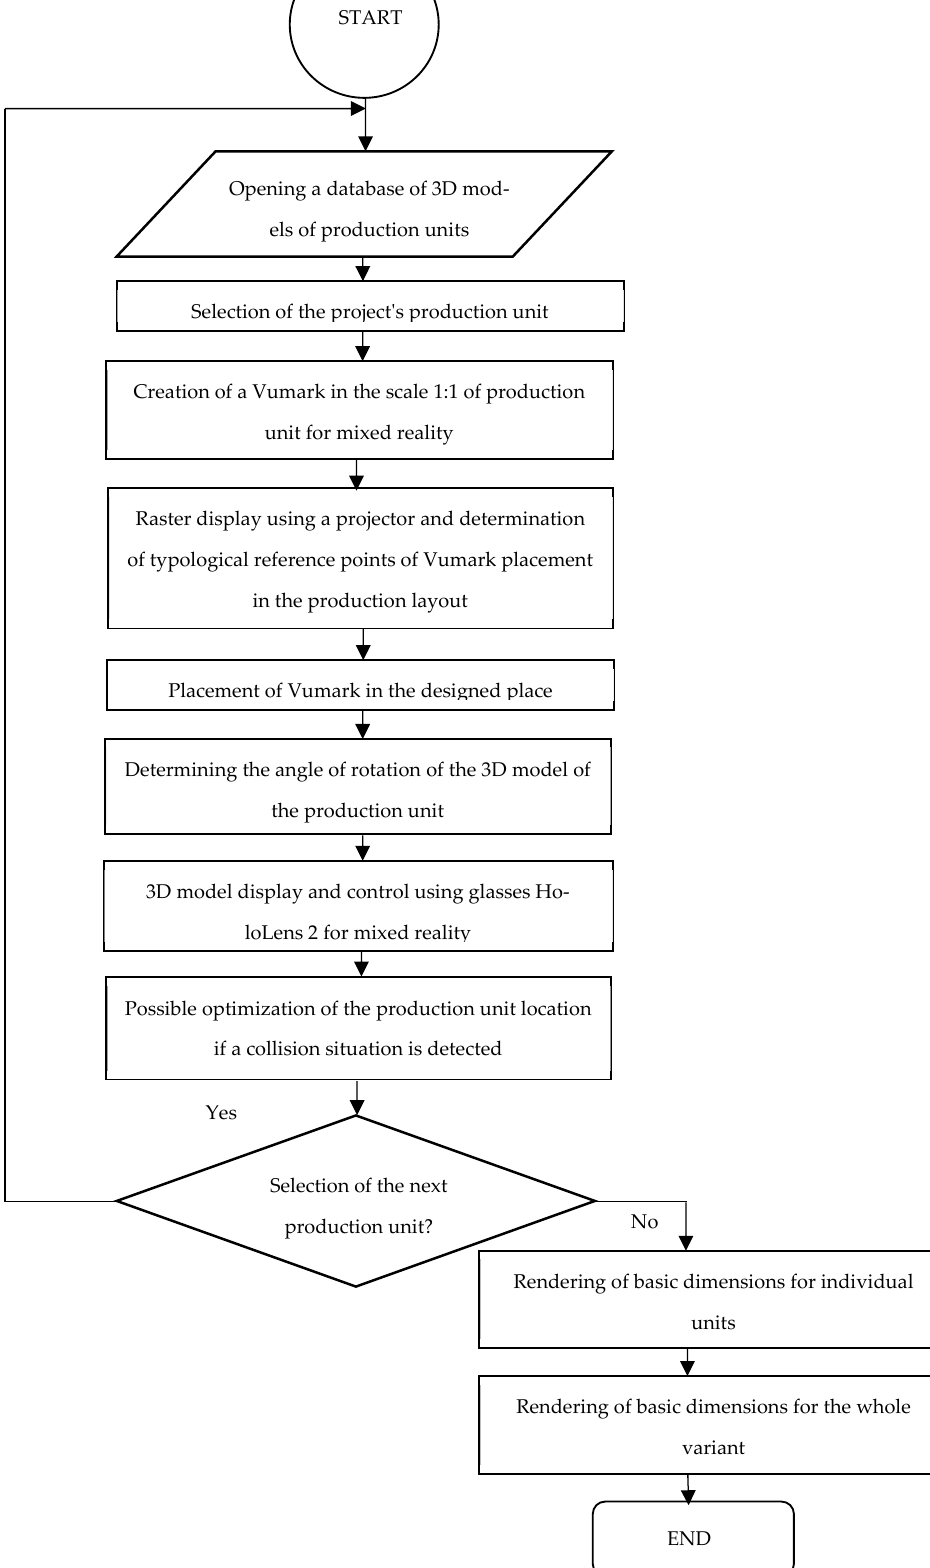
Figure 16. Flowchart of application the virtual model to the real environment .